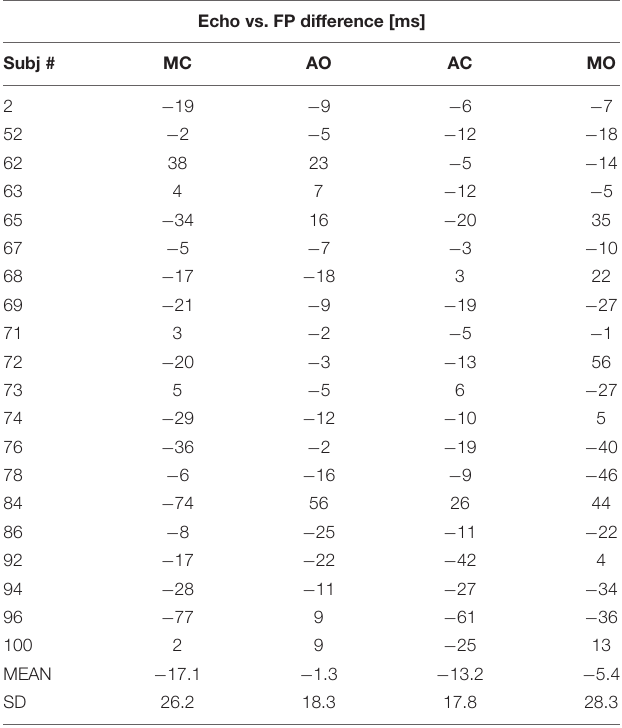
TABLE 4 | Echo vs. FP differences for each valve event in patients: individual data, group mean, and SD . Echo vs. FP difference [ms]